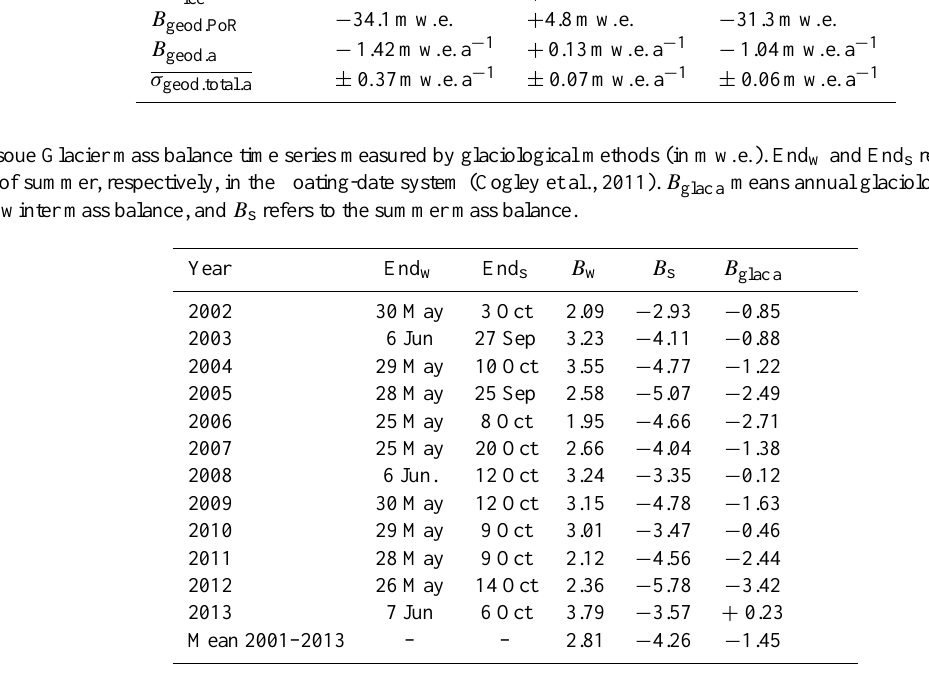
(Table 1). Post-corrections, based on a 40 km distant base from the French geodetic permanent network (RGP), were applied. Two (m) DEMs were generated from the elevation point canvas, applying the same interpolation method previ- ously mentioned. The estimated random error on the DGPS DEM is 0.6